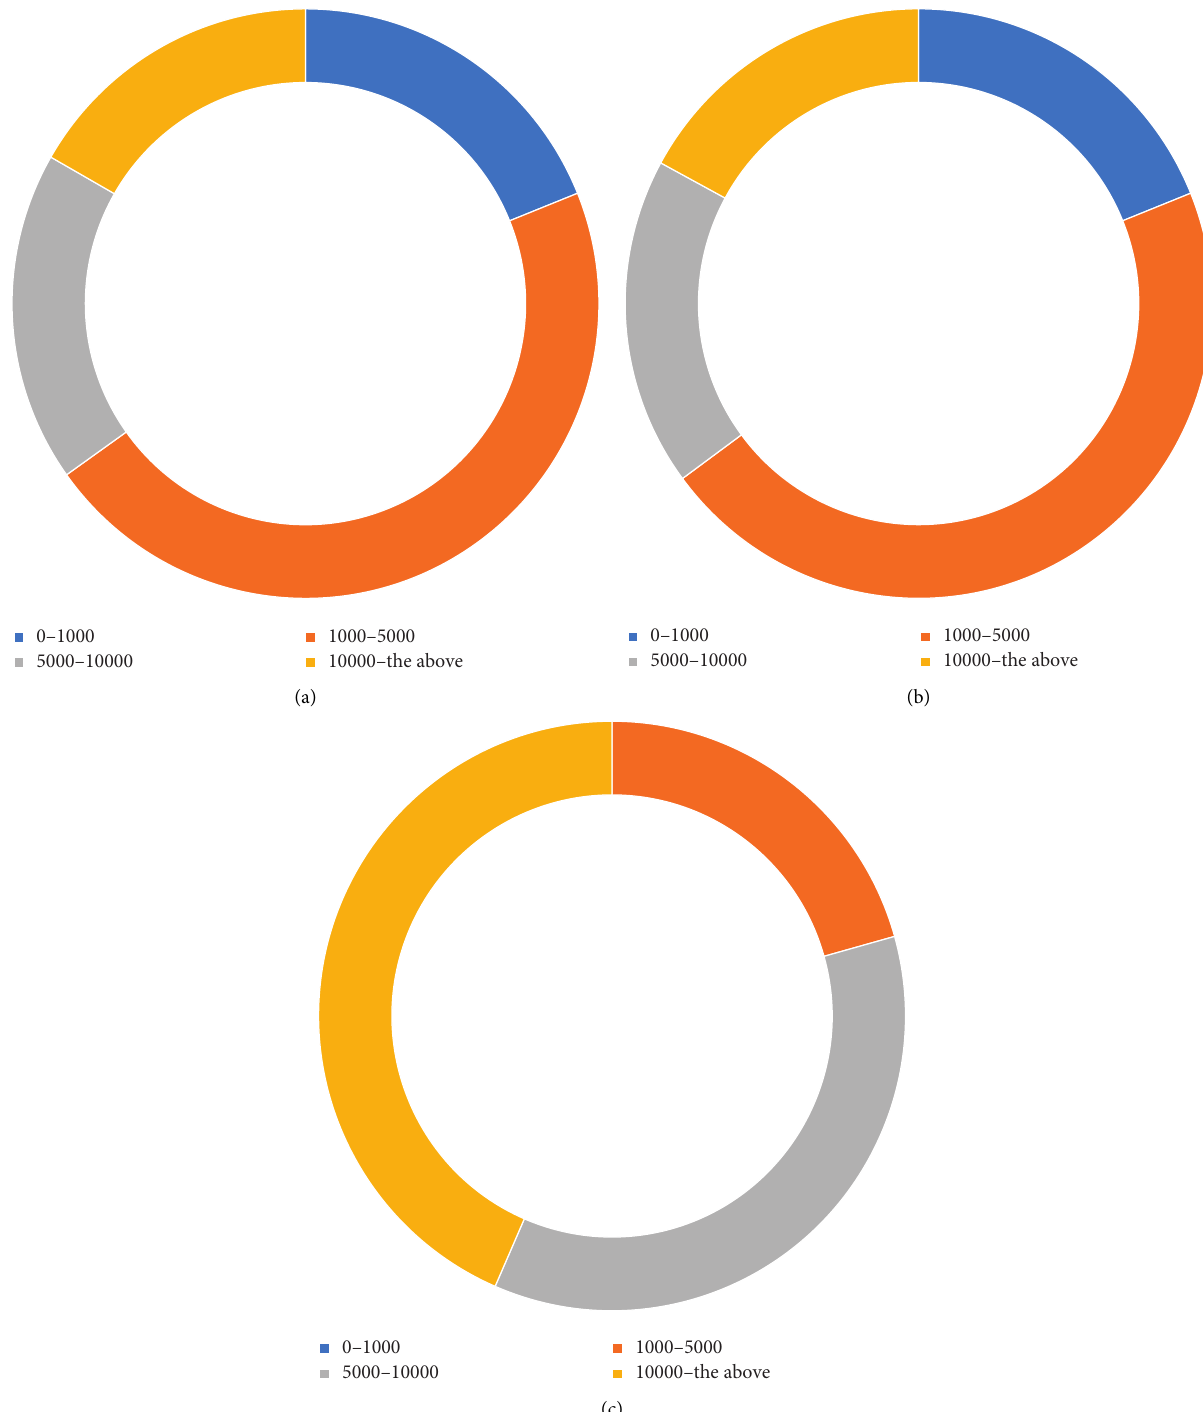
Figure 3: The money spent on maintaining social networks. (a) Social networks. (b) Emotional network. (c) Instrumental